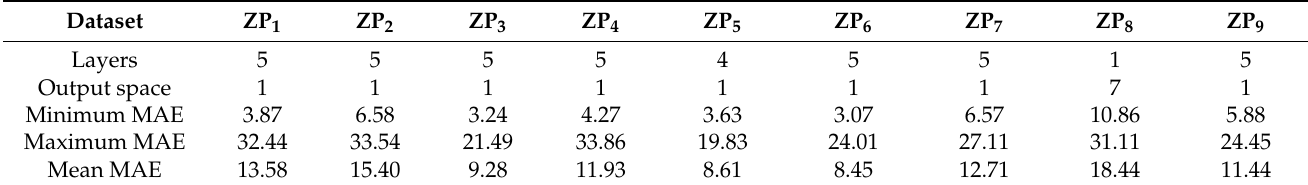
Table 3. Simulation results of grid search algorithm parameters of the LSTM network.